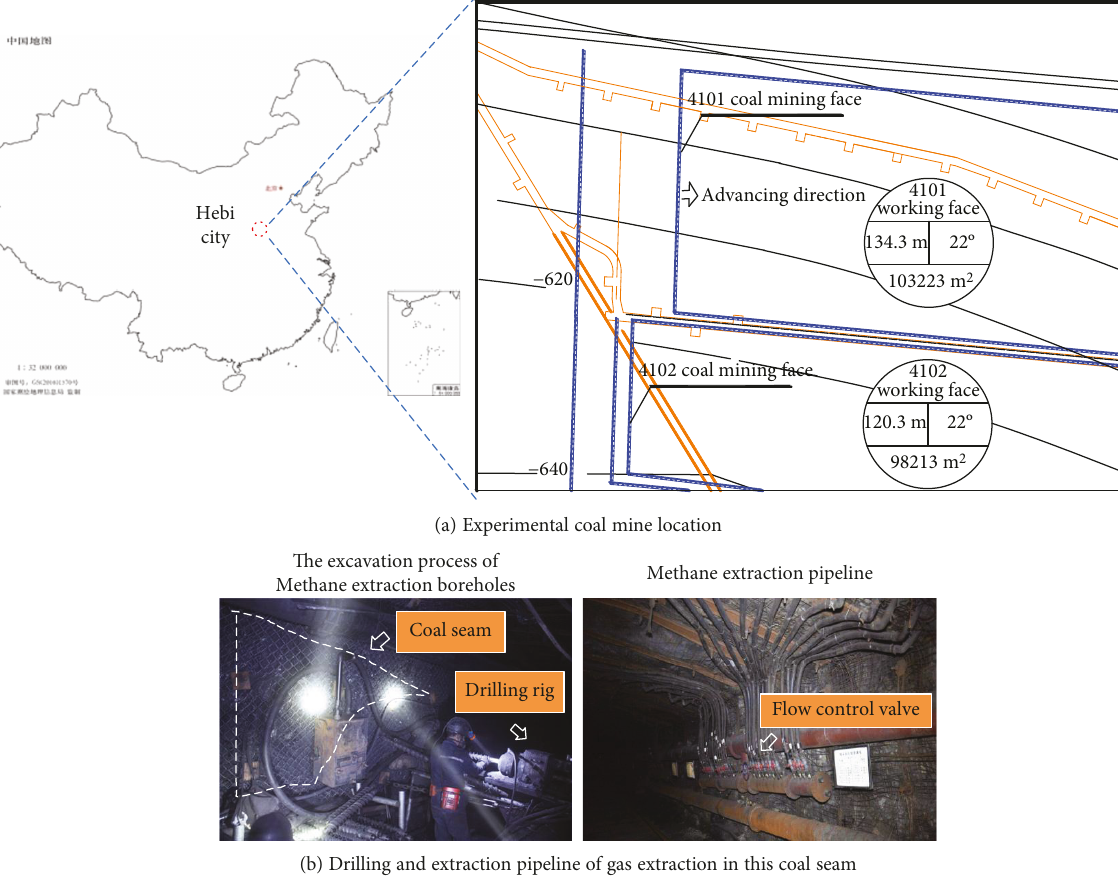
Figure 1: The location and extraction conditions of coal mining face.